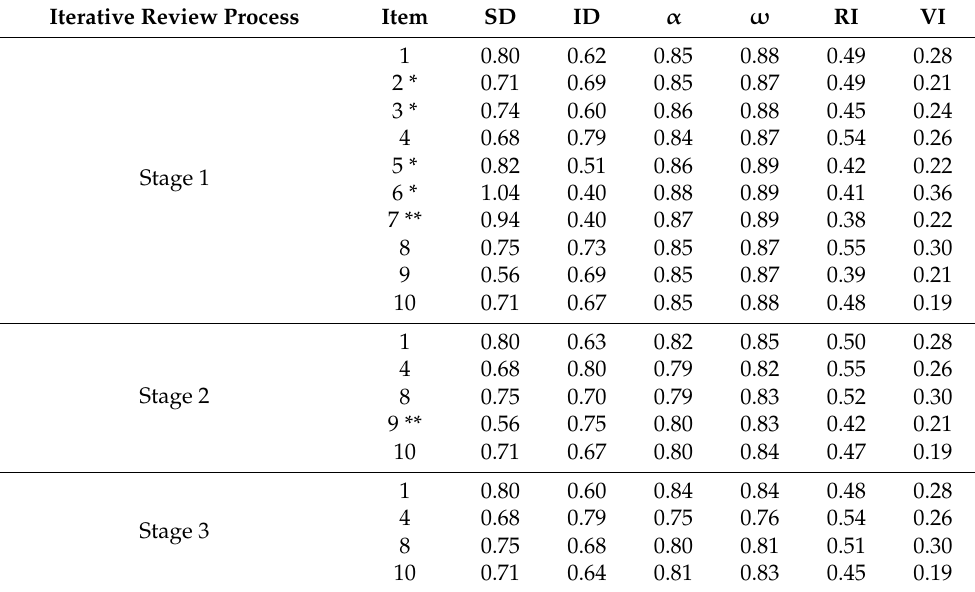
Table 2. Descriptive analysis of items presenting DIF eliminated during the iterative review process for factor 1—work